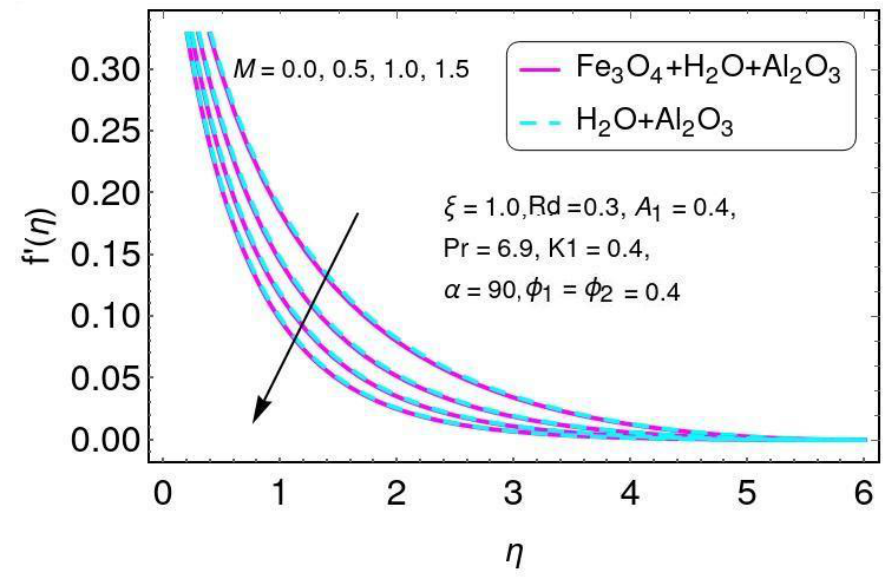
Figure 2. Characteristics of M for the velocity distribution f (cid:48) .